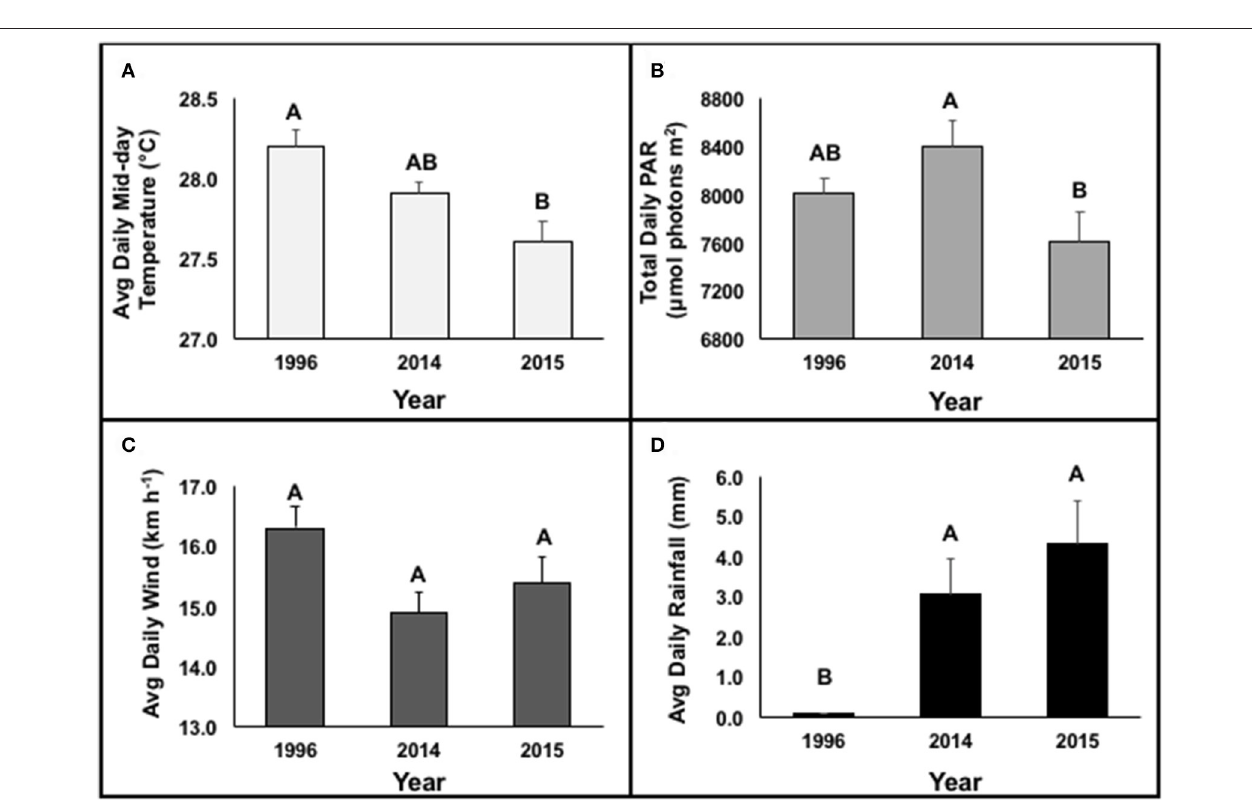
FIGURE 6 | Environmental characteristics of average daily mid-day temperature ( ◦ C) (A) , total daily PAR ( µ mol photons m − 2 ) (B) , average daily wind (km h − 1 ) (C) and average daily rainfall (mm) (D) between 1 Aug and 1 Nov during documented bleaching events (1996, 2014, and 2015). Levels not connected by the same letter are significantly different at p < 0.05. Data was obtained from Hawai‘i Institute of Marine Biology Weather Station (http://www.pacioos.hawaii.edu/weather/obs-